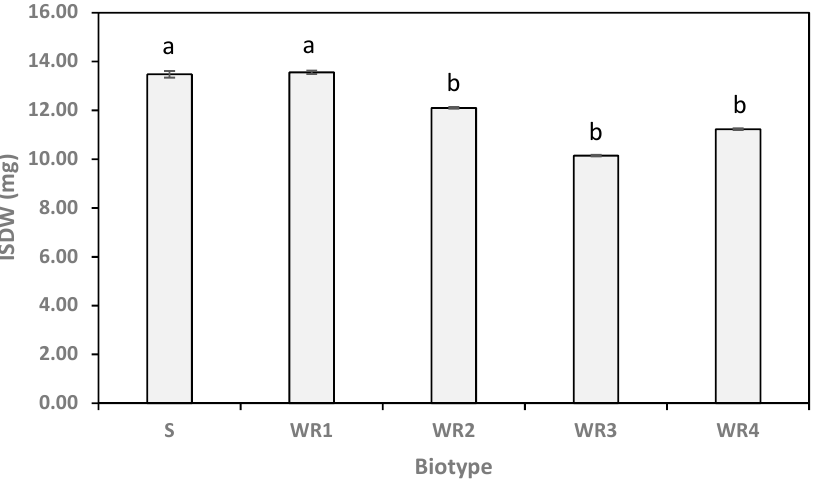
Figure 4. The average of initial seed dry weight (ISDW) among five Avena sterilis ssp. ludoviciana biotypes (susceptible biotype (S) or resistant biotypes (WR 1 –WR 4 )) produced in 2015 and 2017. The symbols represent the mean of three replicates. Error bars represent standard deviations. Means followed by the same letter are not significantly different according to the least significant difference (LSD) test. Table 5. Results of analysis of variance (mean squares) for initial seed dry weight (ISDW), seed remnants dry weight (FSDW), seedling dry weight (SLDW), the weight of mobilized seed reserve (MSR), the conversion efficiency of mobilized (CEM), and the fraction of seed reserve (FSR).